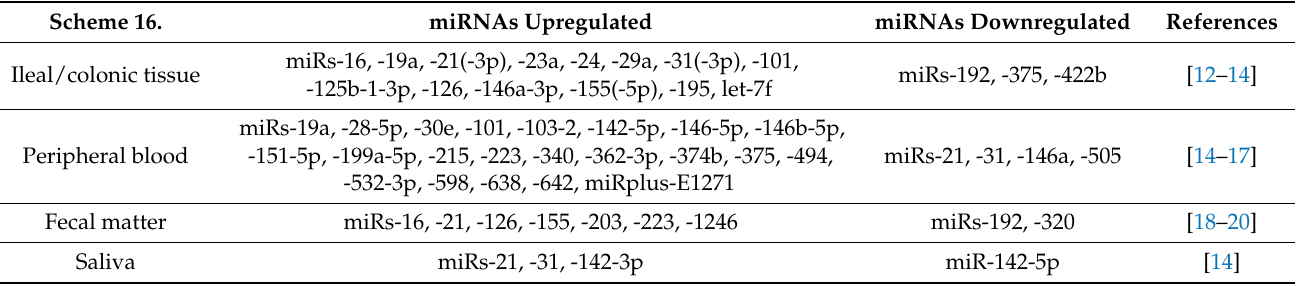
Table 1. miRNAs dysregulated in UC across various tissue samples. Scheme